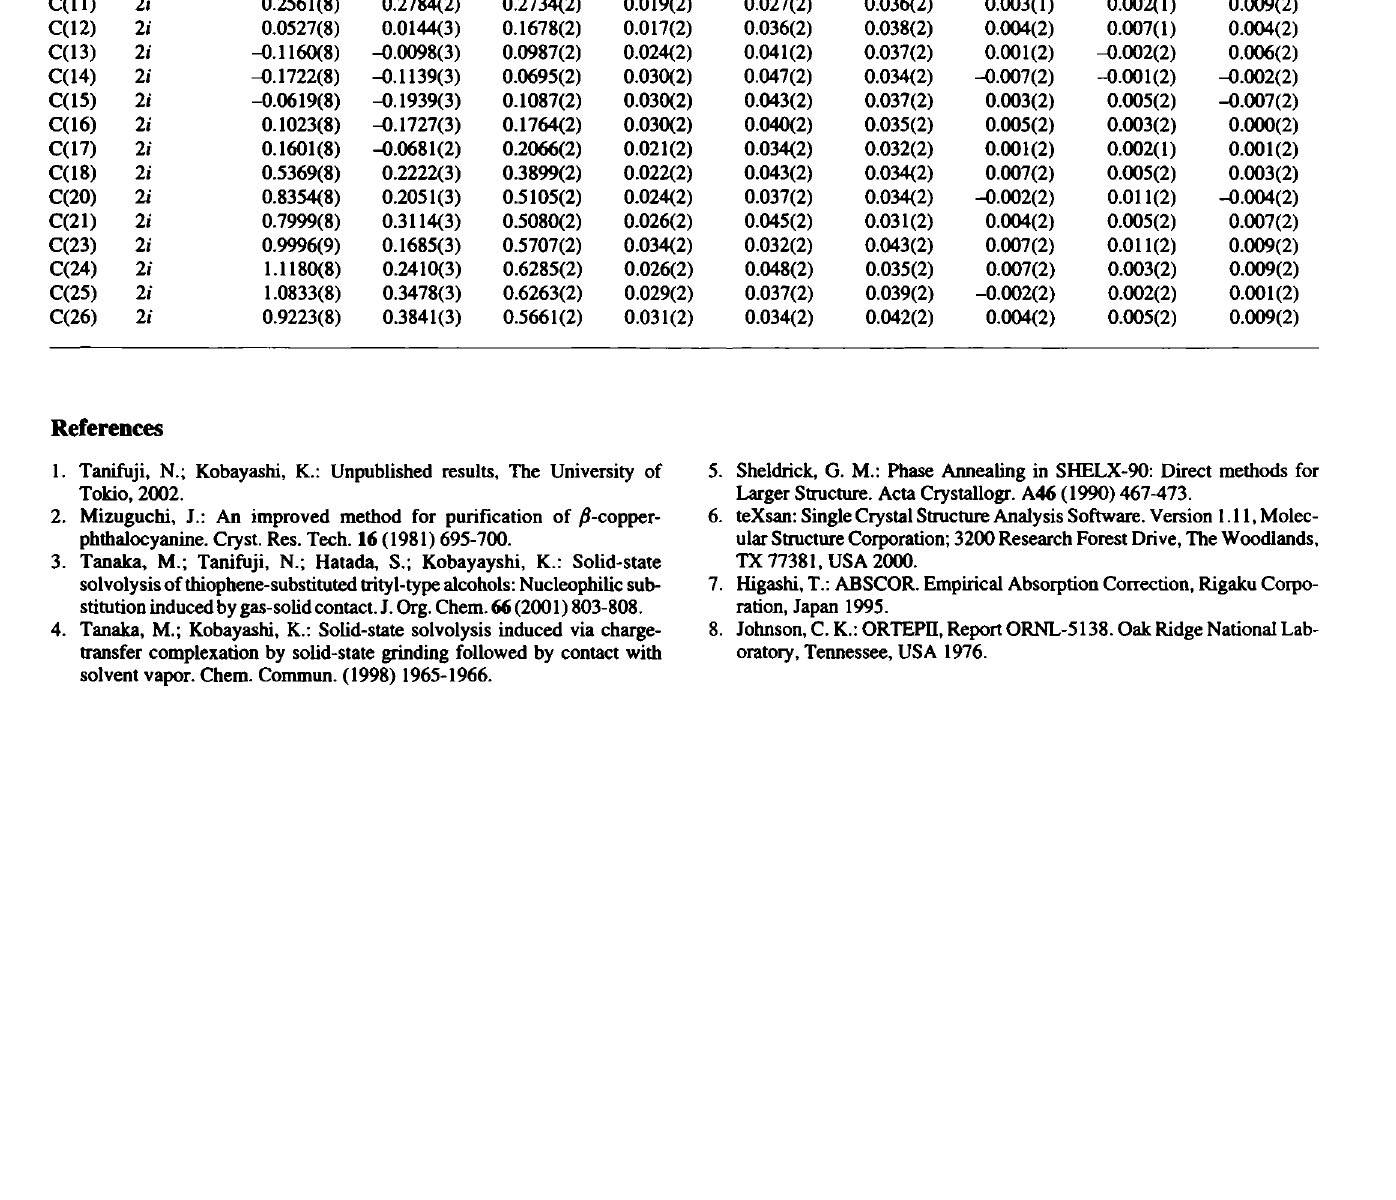
Table 3. Atomic coordinates and displacement parameters (in Ä 2